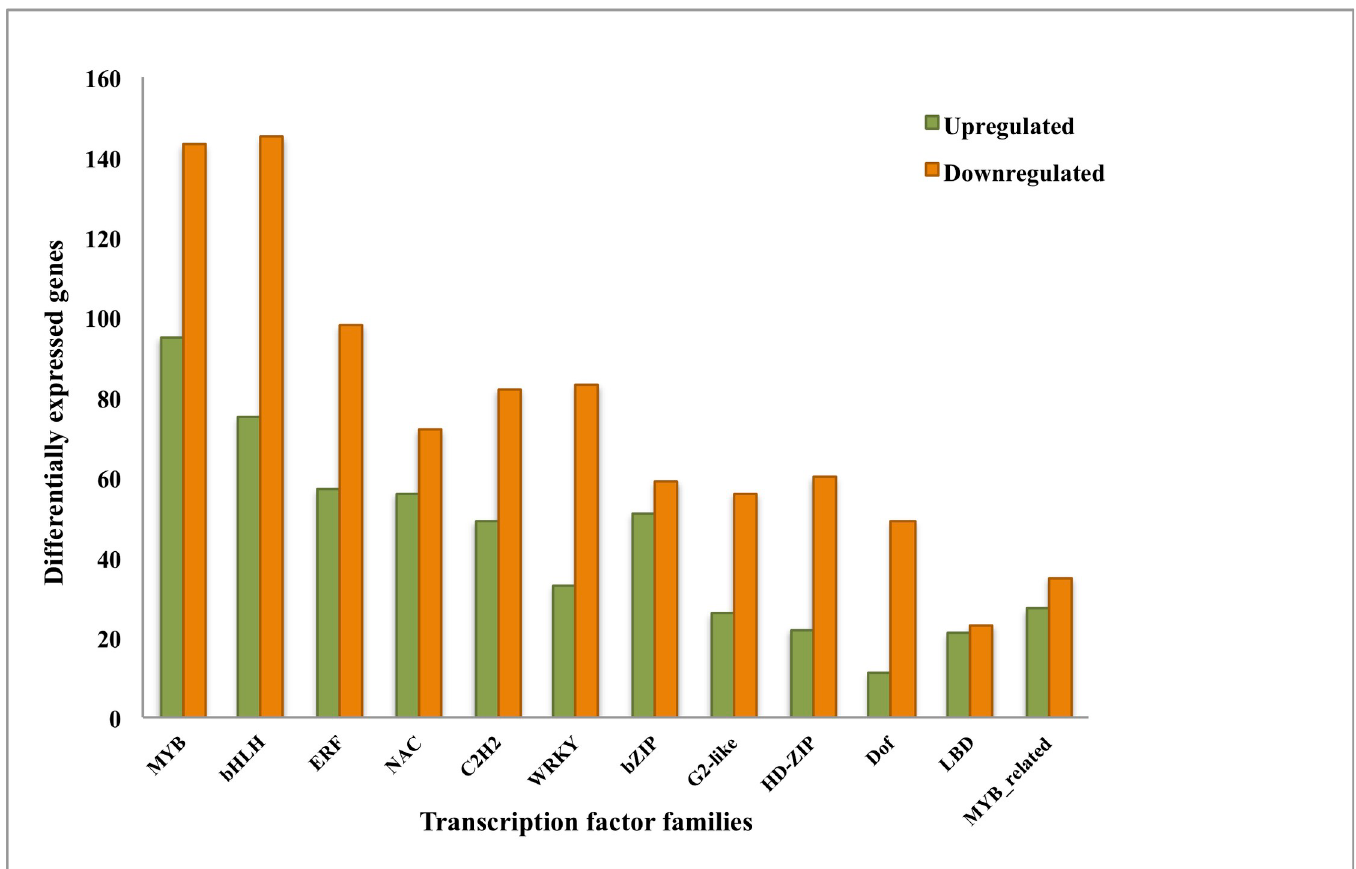
Fig 5. Transcription factors expressively correlated with cv. Nendran ripe fruit-pulp. Orange bars represent down-regulated genes while green bars represent up- regulated genes.